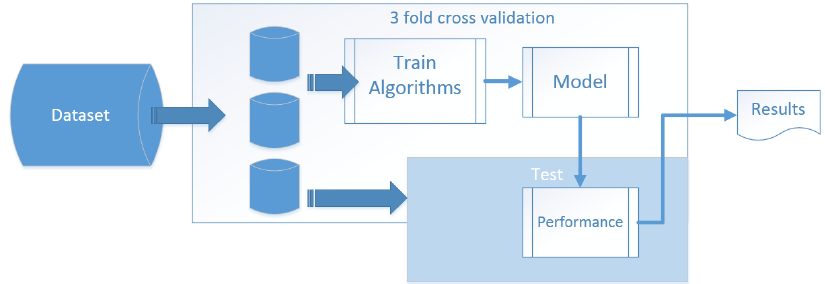
Figure 20. Processing flow chart of 3-fold cross validation.